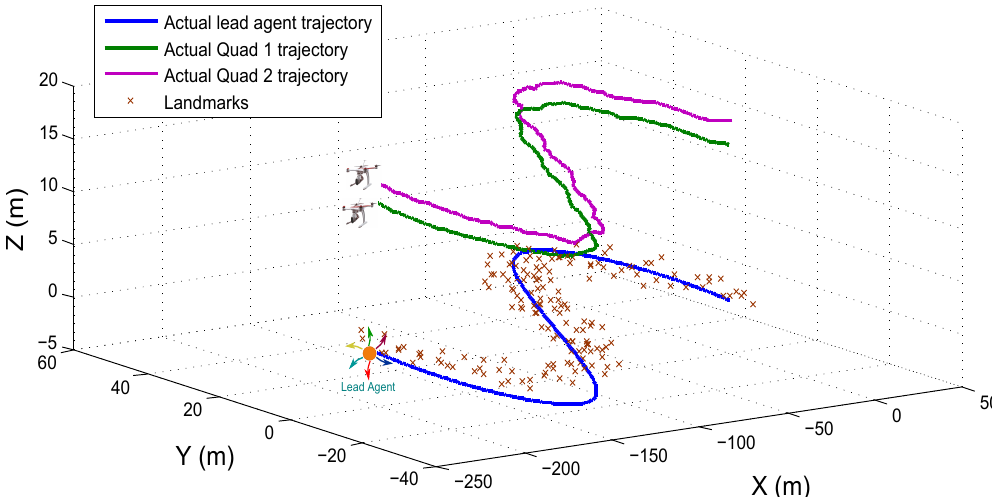
Figure 13. Trajectories followed by the lead agent, the Quad 1 and the Quad 2 with the system in closed-loop.